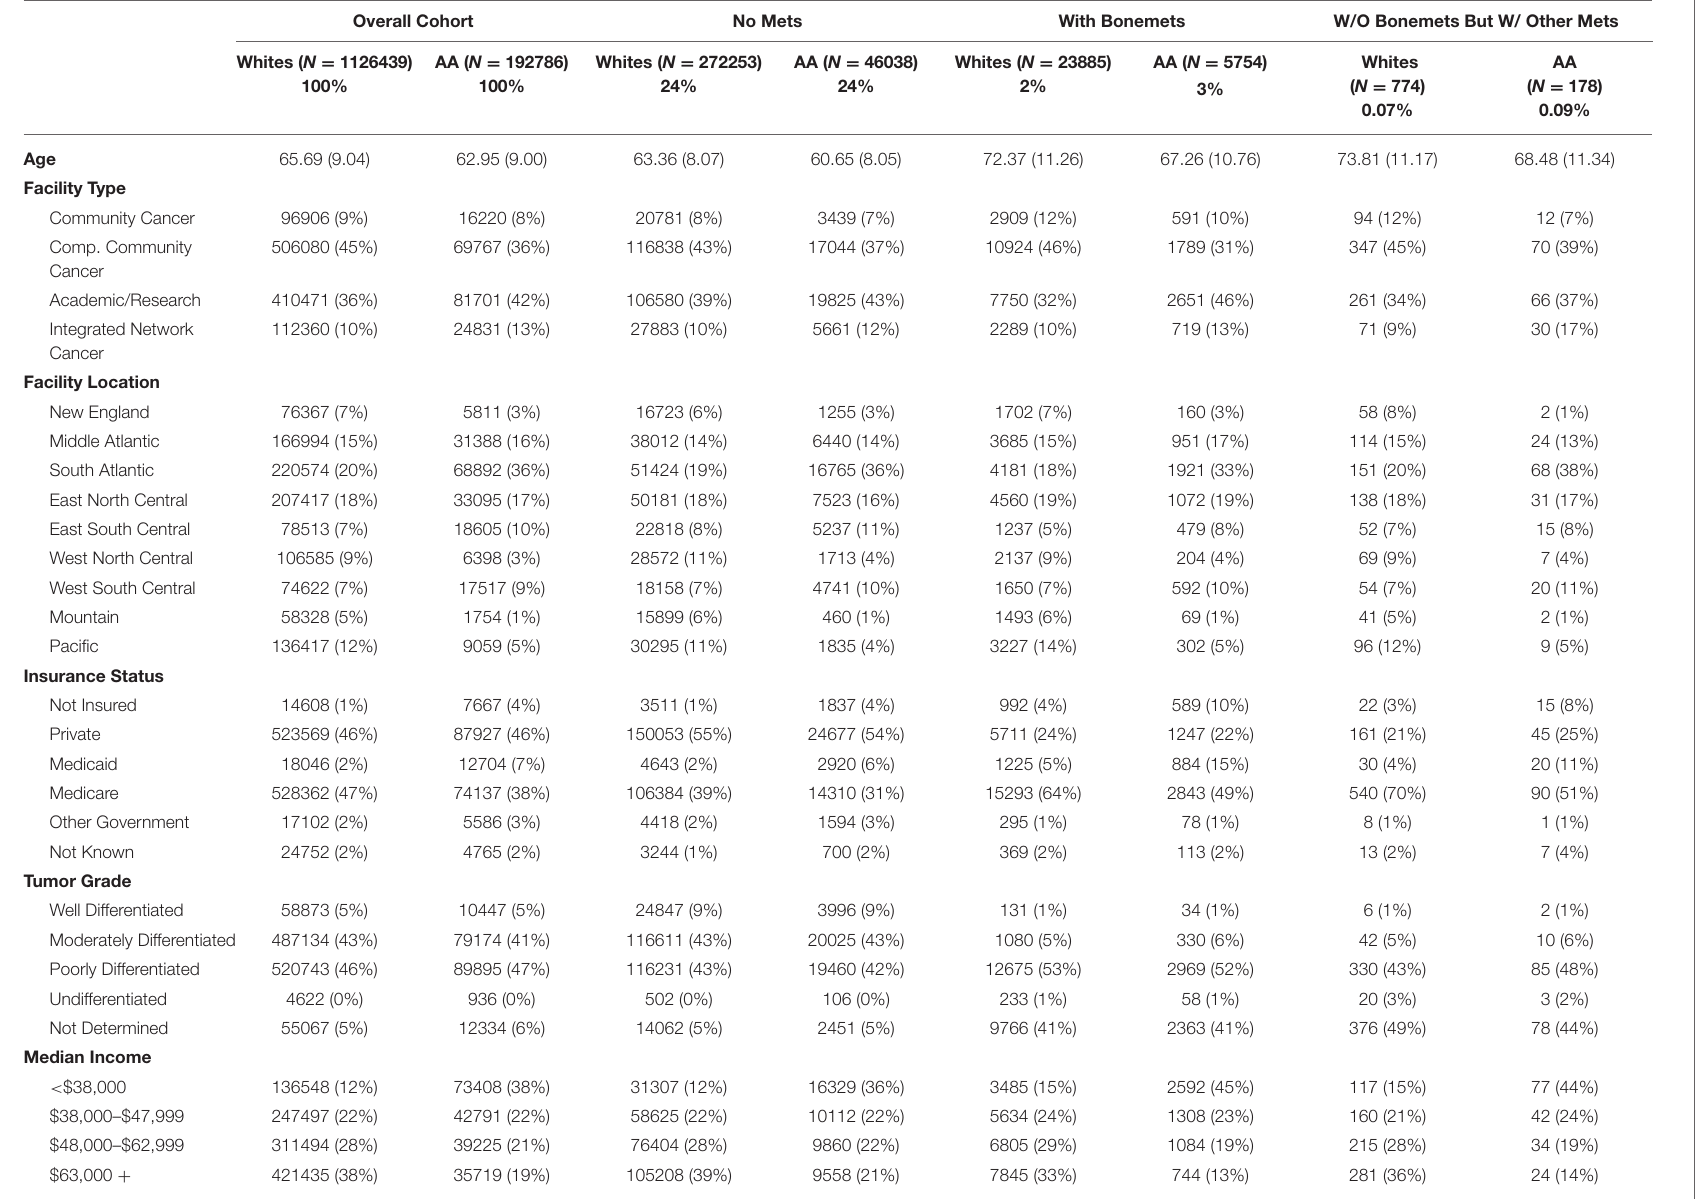
TABLE 1 | Sample participant characteristics (AA: African